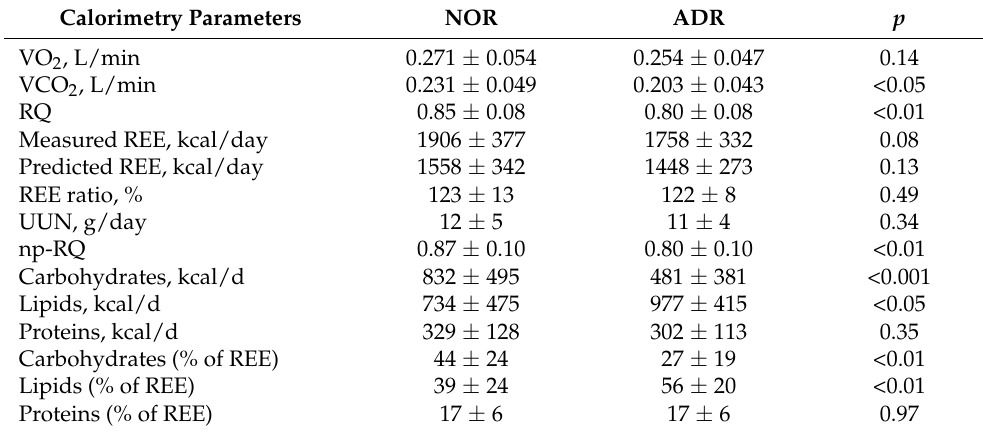
Table 6. Results from indirect calorimetry in hypermetabolism according to catecholamine phenotype. Calorimetry